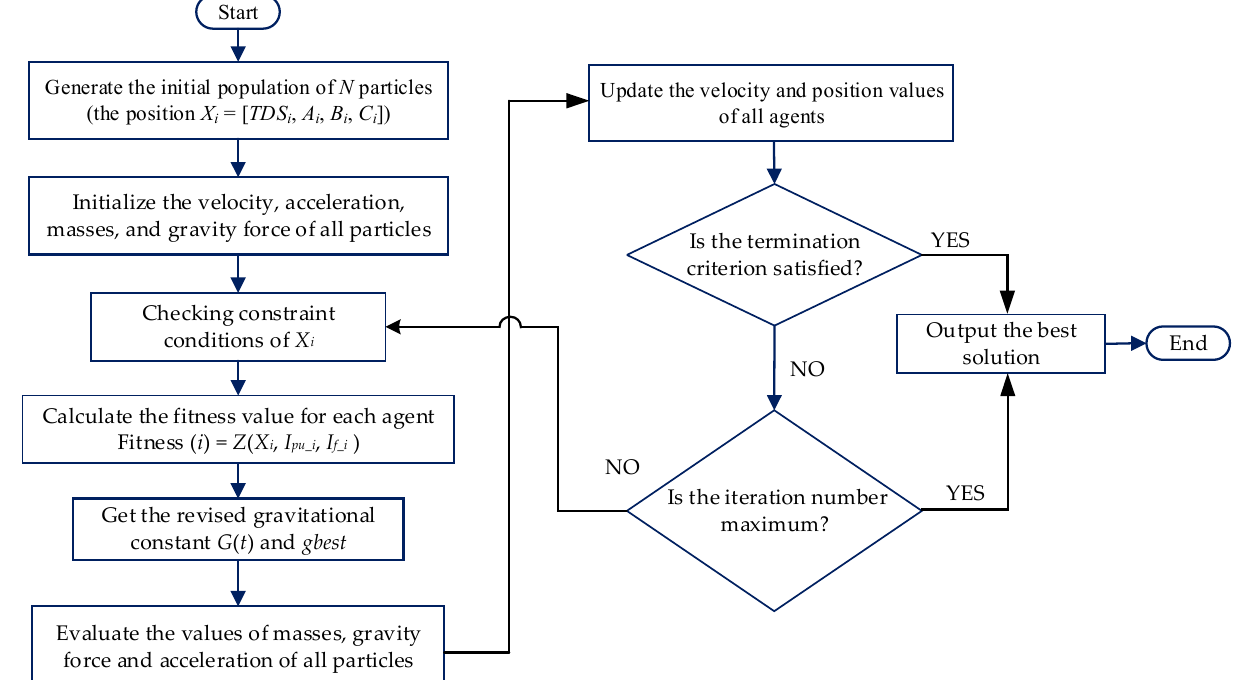
Figure 7. A flow chart of hybrid PSO-GSA applied to the proposed ASPC approach of OCRs.